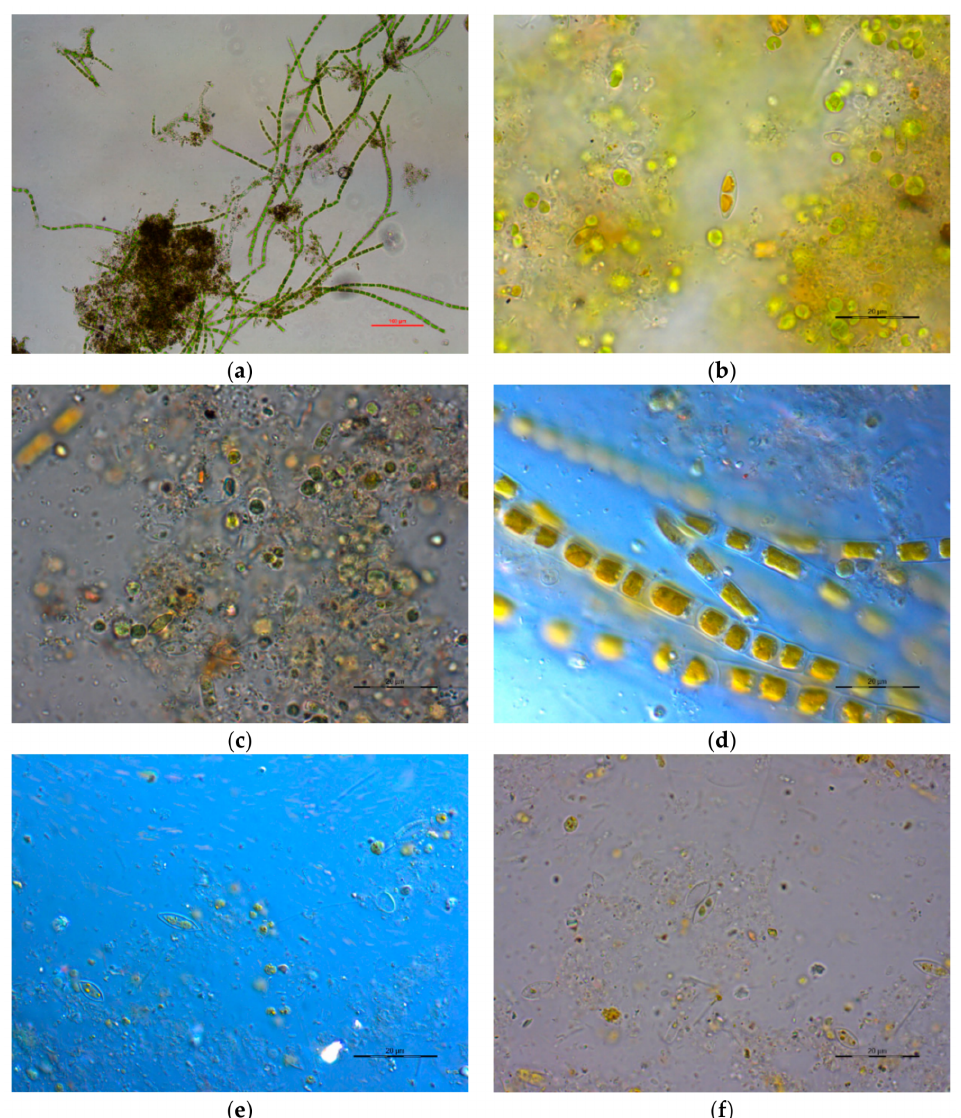
Figure 3. Microscopic images of microalgae before ( a , b ) and after ( c , d ) the thermal pretreatment, along with the digestates from untreated microalgae AD ( e ) and thermally pretreated microalgae AD ( f ) at a HRT of 30